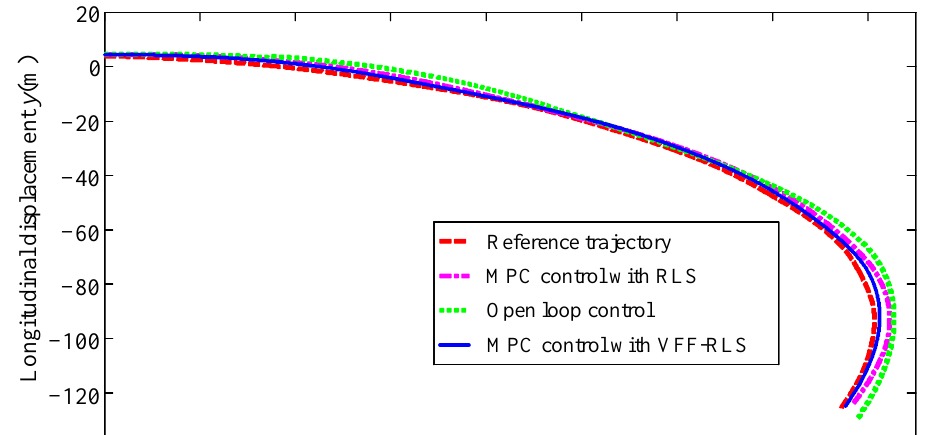
Figure 13. Yaw rate under Scenario A.